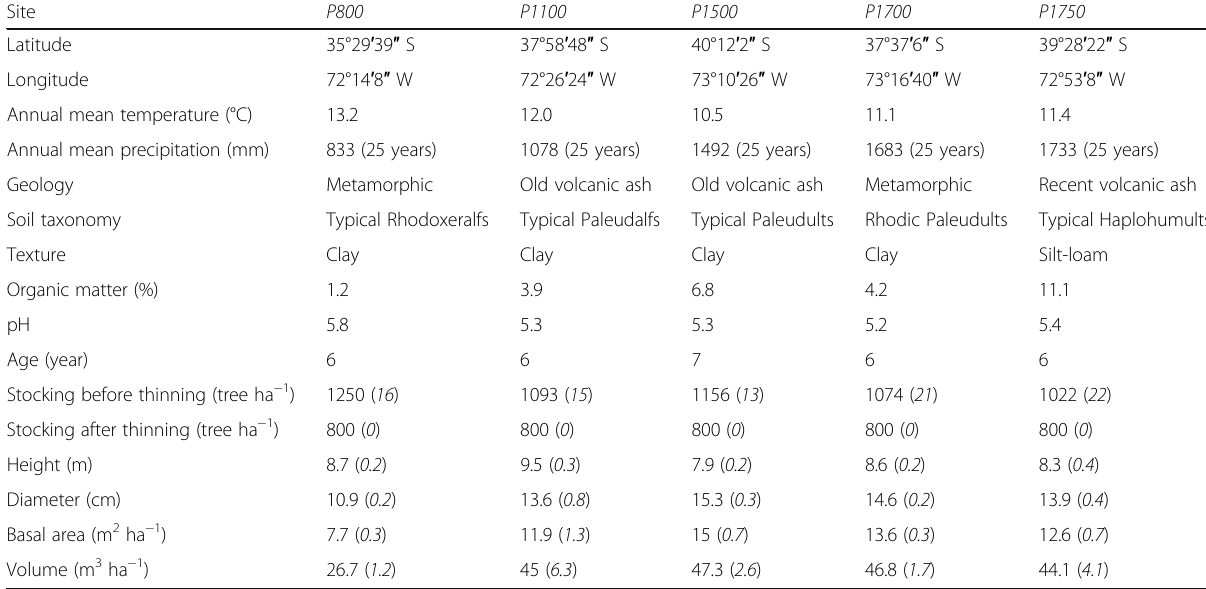
Table 1 Site and stand